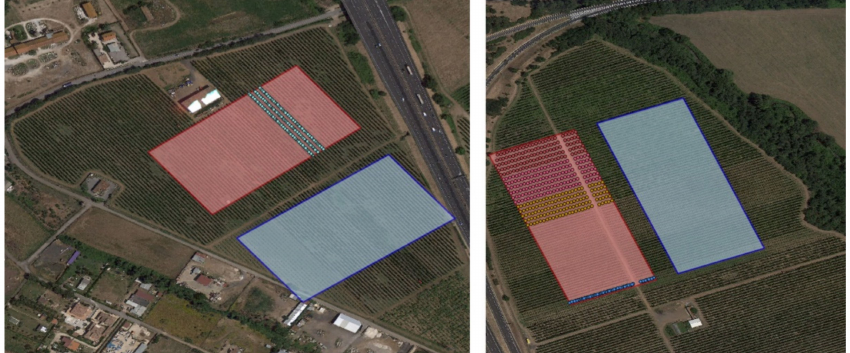
Figure 5. Example of maps produced as output of DSS for block A on July 14 (on the left) and for block B on August 4 (on the right). Red areas are DSS-assisted plots, blue areas are conventional plots. Cultivars to be treated according to the DSS recommendation are highlighted with coloured, dotted stripes. Background image from Google